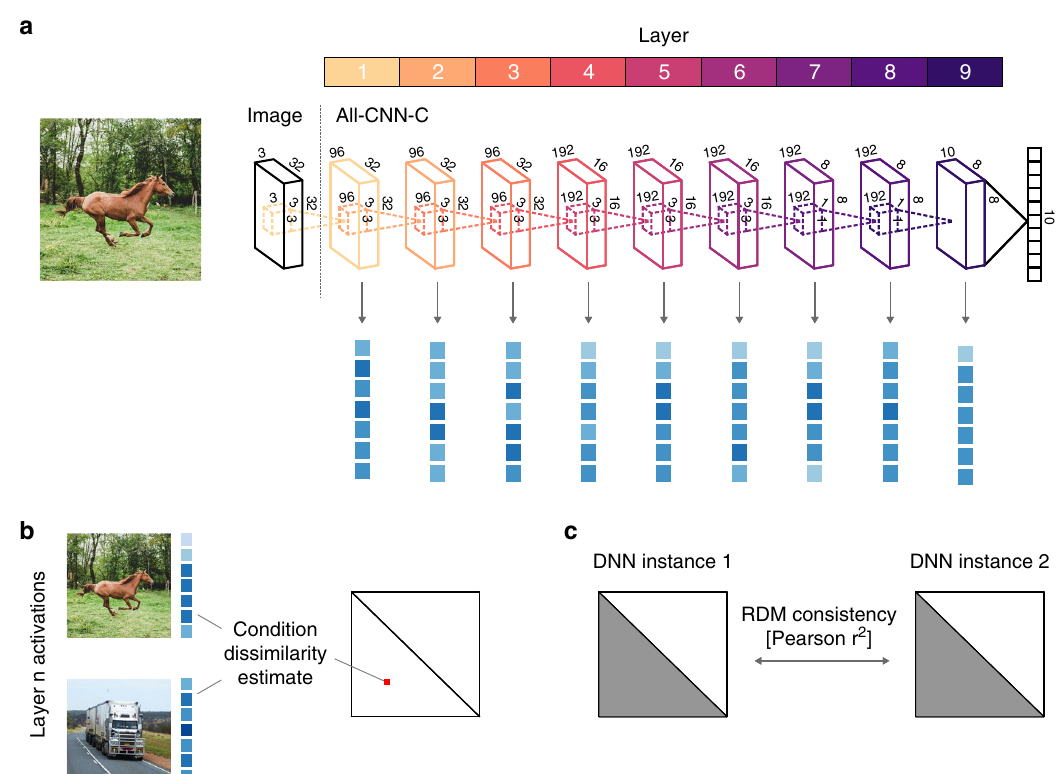
Fig. 1 Comparing network-internal representations using RSA and representational consistency. a Our comparisons of network-internal representations were based on their multivariate activation patterns, extracted from each layer of each network instance as it responded to each of 1000 test images. b These high-dimensional activation vectors were then used to perform a representational similarity analysis (RSA). The fundamental building blocks of RSA are representational dissimilarity matrices (RDMs), which store all pairwise distances between the network ’ s responses to the set of test stimuli. Each test image elicits a multivariate population response in each of the network ’ s layers, which corresponds to a point in the respective high-dimensional activation space. The geometry of these points, captured in the RDM, provides insight into the nature of the representation, as it indicates which stimuli are grouped together, and which are separated. c To compare pairs of network instances, we compute their representational consistency, de fi ned as the shared variance between network RDMs.